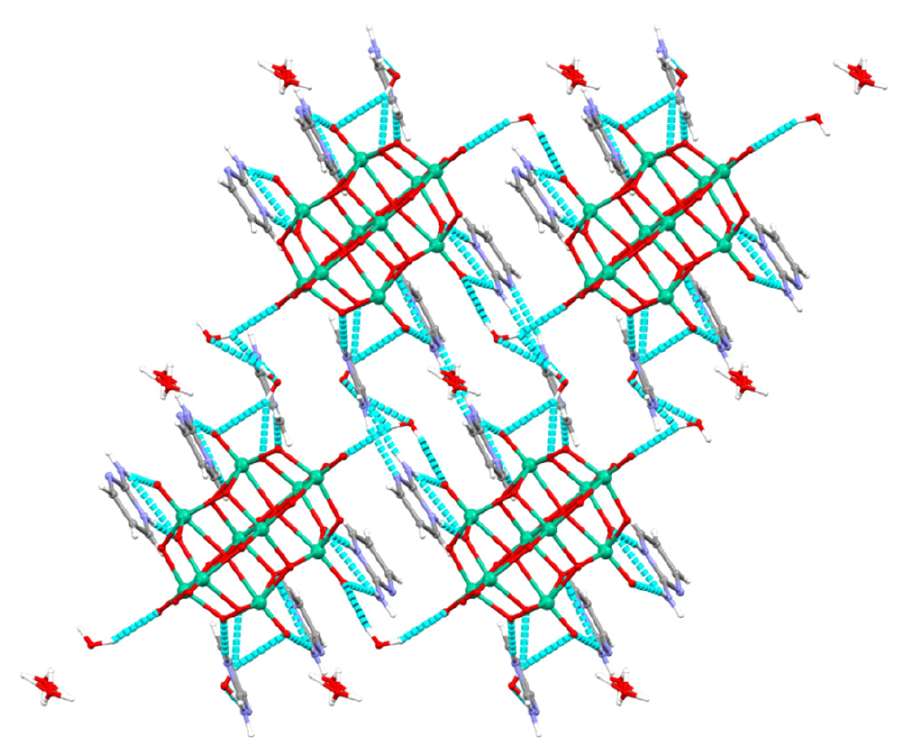
Figure 5. View of the supramolecular structure along the crystallographic a -axis, where all hydrogen bonds forming in Compound 1 can be observed (blue dashed line). Vanadium atoms are represented in